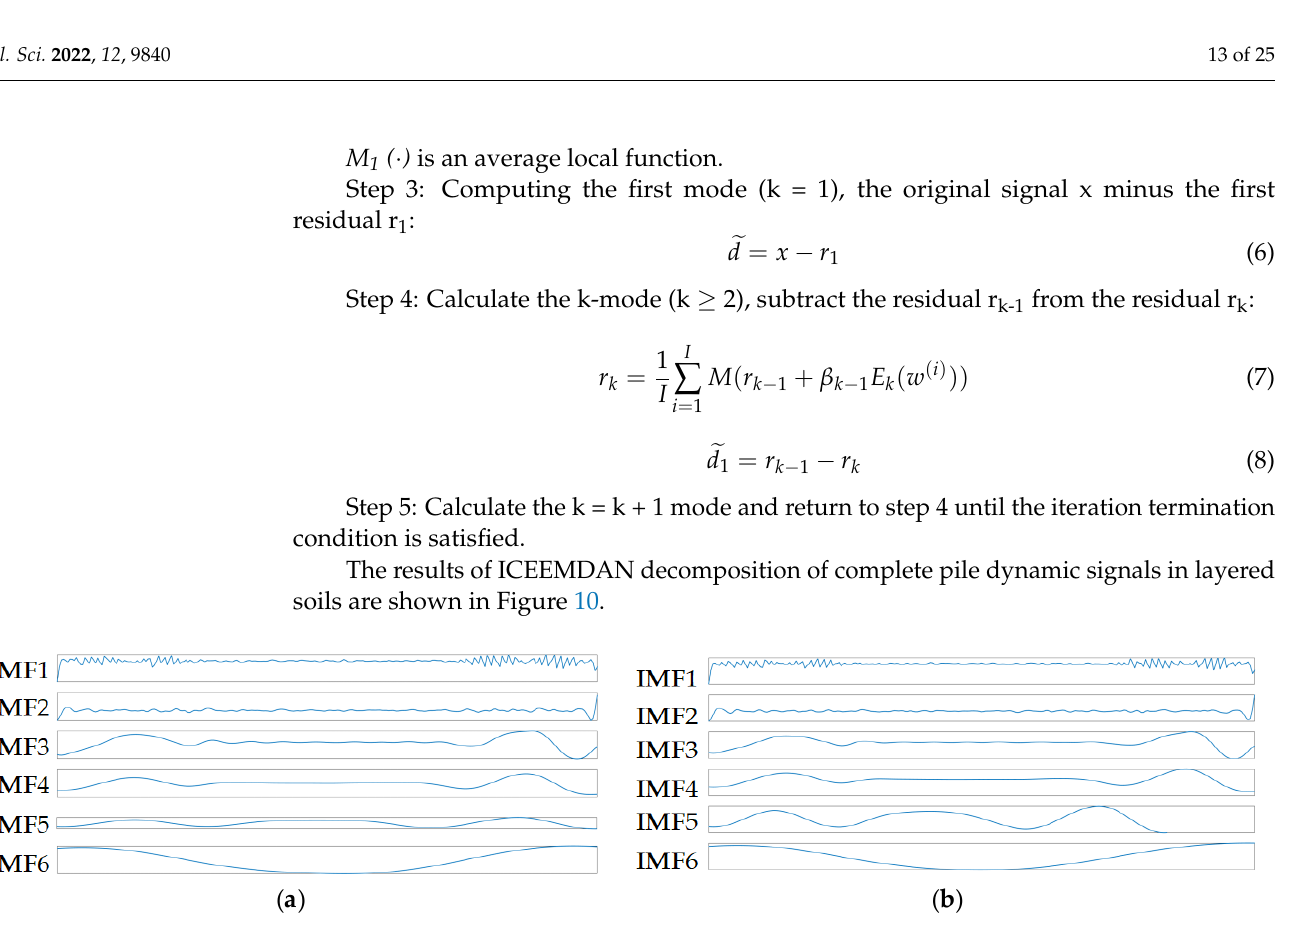
Figure 10. ICEEMDAN decomposition of reflective wave signal of complete pile: ( a ) Soil boundary position near pile tip; ( b ) Soil boundary position near pile base.